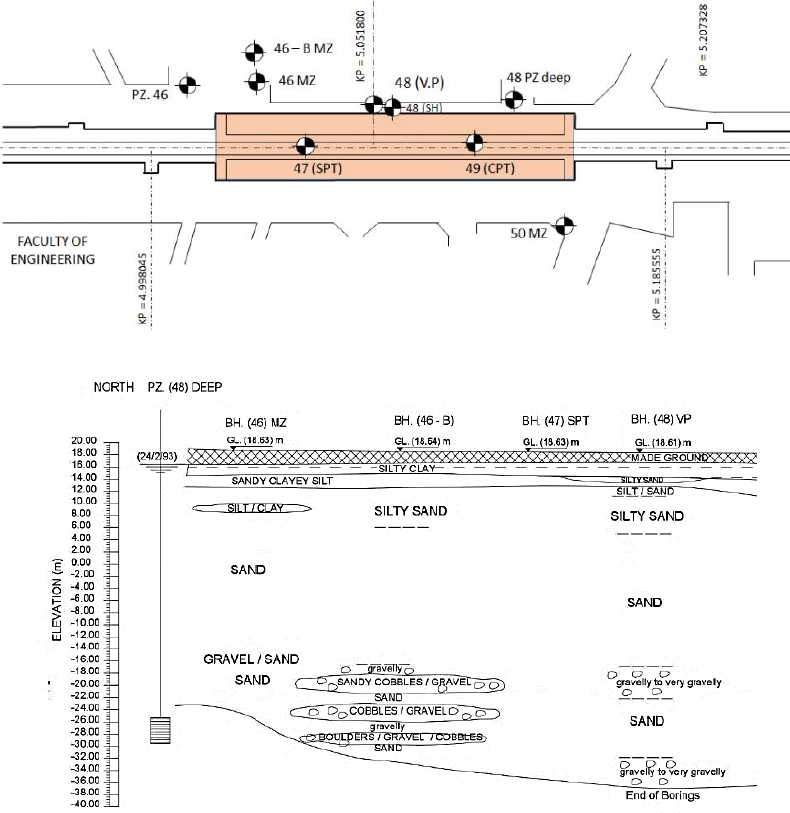
Figure 3. Layout plan, and the elevation of the borehole locations at Rod El Farag subway station [30].